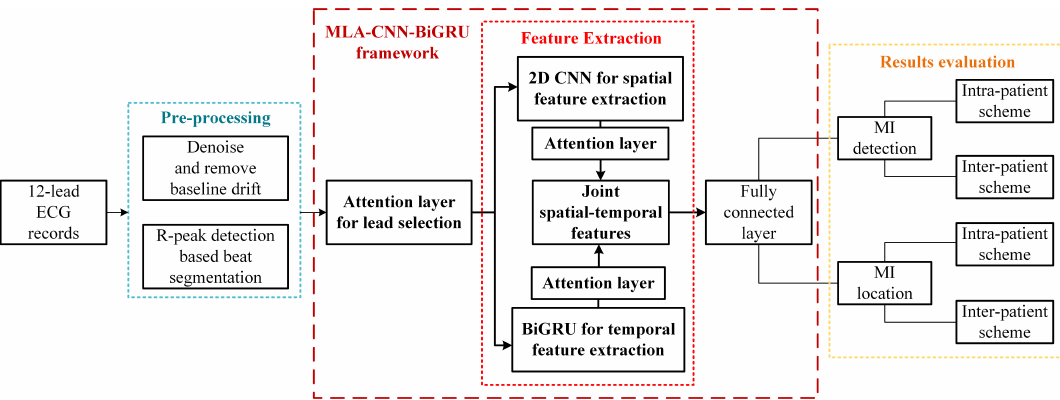
Figure 1. Overall scheme of the